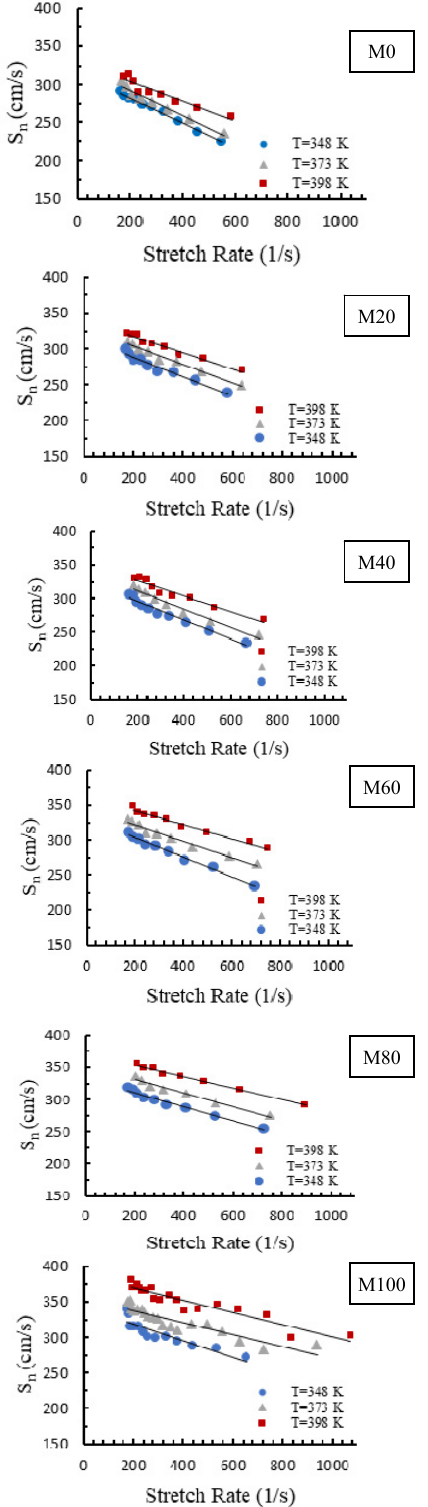
Figure 11. Stretched flame speed versus stretch rate for various initial temperatures and blending